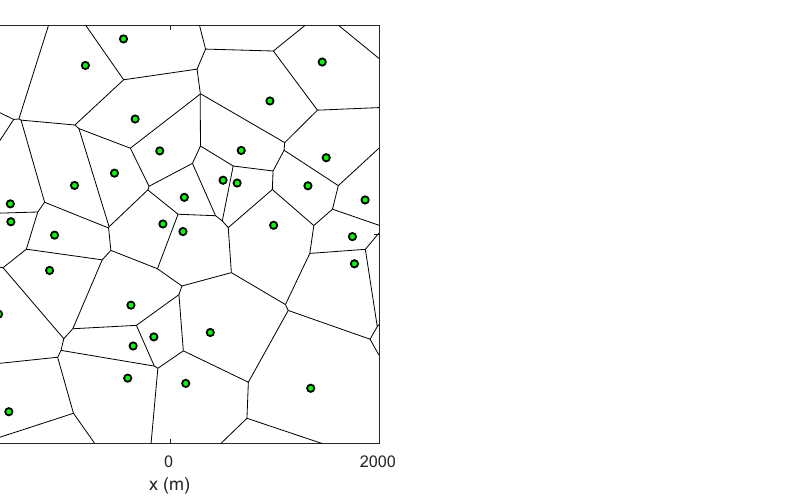
Figure 1. An example of a Voronoi cell area with 40 GNs distributed in an area of 4000 m × 4000 m.